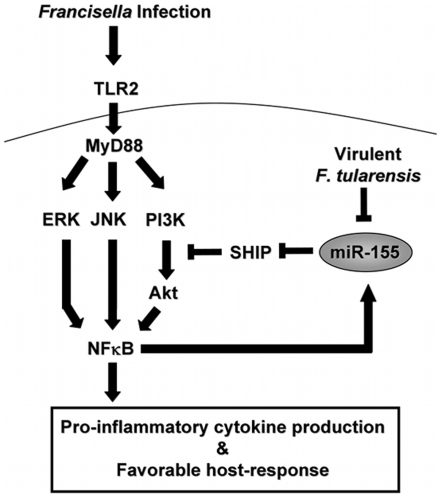
Model of miR-155 induction and function during Francisella infection.
Francisella is recognized on the host cell surface by TLR2. The signal is transmitted through the adaptor protein MyD88. Subsequently MAPKs, PI3K and Akt are activated, which leads to enhanced NFκB activity, inflammatory cytokine production, and effective host response. SHIP negatively regulates the activation of Akt to prevent effective host response. During Francisella infection miR-155 is induced through the TLR signaling pathway, PI3K/Akt, ERK, JNK, and NFκB. MiR-155 induction in turn down-regulates SHIP to promote the activation of the PI3K/Akt pathway and inflammatory cytokine production. The highly virulent F. tularensis suppresses or subverts the induction of miR-155 in human monocytes, while the relatively avirulent F. novicida does not.